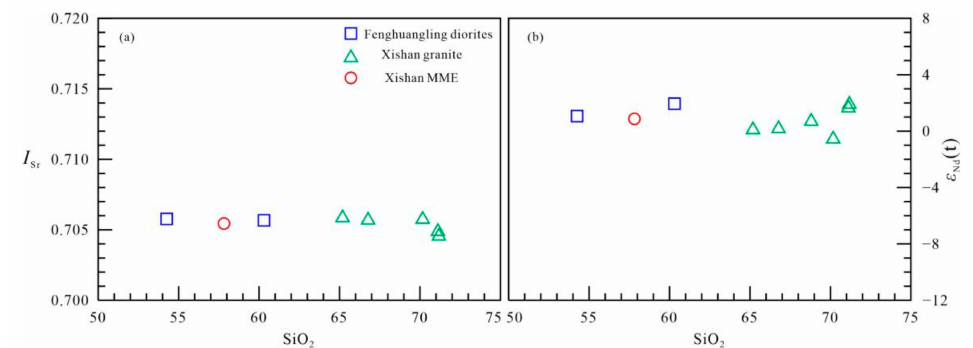
Figure 10. SiO 2 versus I Sr diagram ( a ) and SiO 2 versus ε Nd(t) diagram ( b ) for the Guiping